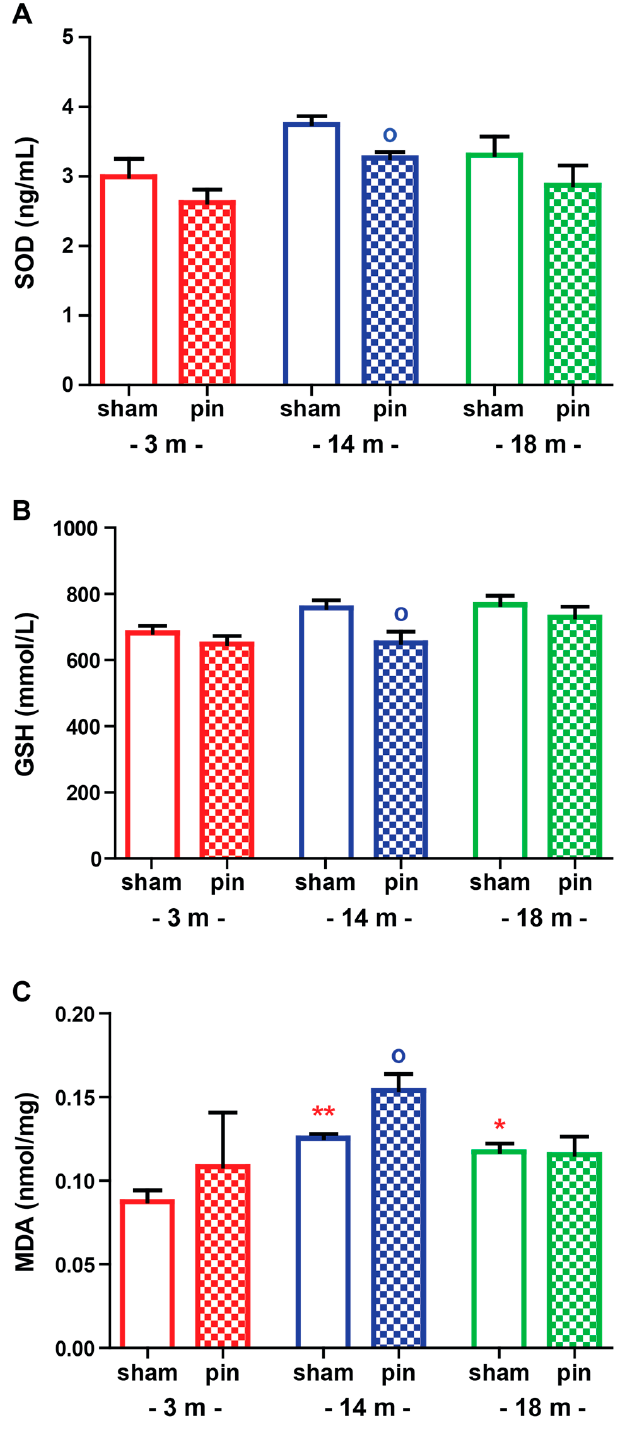
Figure 5. The effect of pin on SOD activity ( A ), GSH level ( B ) and MDA level ( C ) in the hippocampus of 3-, 14- and 18-month-old rats tested in ELISA. Data are presented as mean ± S.E.M. * p = 0.0284, 14-month-old sham compared to matched 3-month-old group; o p = 0.0108, 14-month-old pin compared to matched sham group ( A ); o p = 0.023, 14-month-old pin compared to matched sham group ( B ); ** p = 0.006, 14-month-old sham compared to matched 3-month-old group; * p = 0.012, 18-month-old sham compared to matched 3-month-old group; o p = 0.05, 14-month-old pin compared to matched sham group ( C ). 3-month-old rats—red; 14-month-old rats—blue; 18-month-old rats—green.